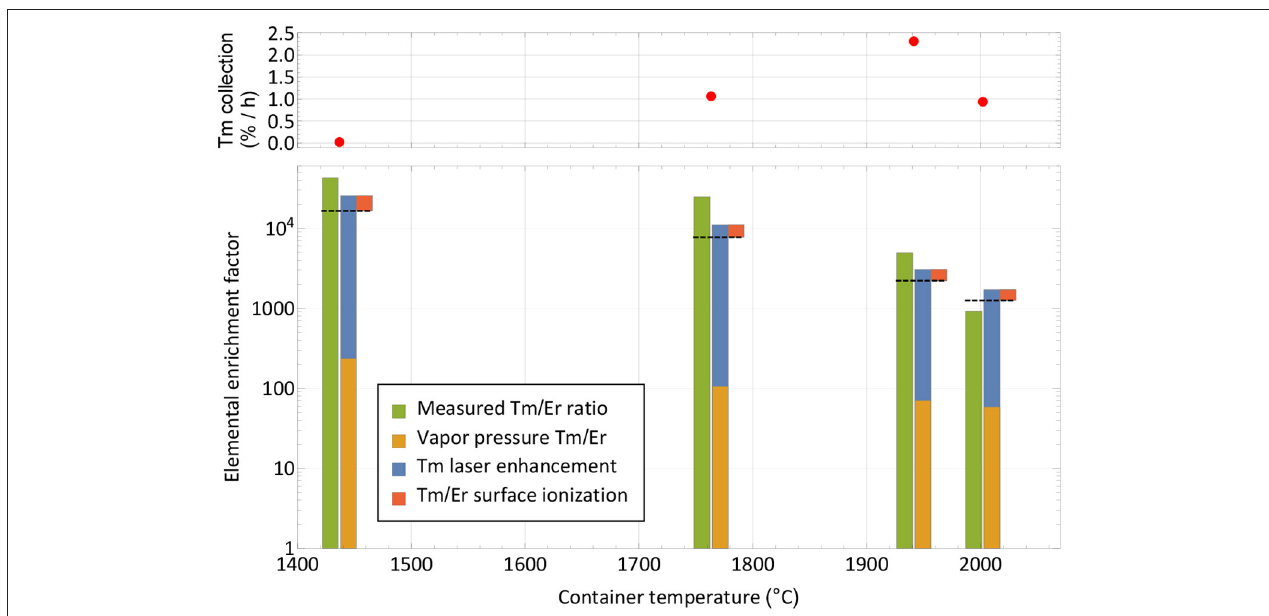
FIGURE 5 | Breakdown of mechanisms involved in the extracted ion beam composition for thulium and erbium. The respective measured elemental enrichment factors (left-hand columns) as extracted from Figure 4 are compared with theoretically expected ones (dashed lines) calculated from vapor pressure, laser enhancement (both favoring thulium) and surface ionization efficiency (favoring erbium). The overall trend is reproduced. The top panel depicts the corresponding collection rate at the points of measurement.